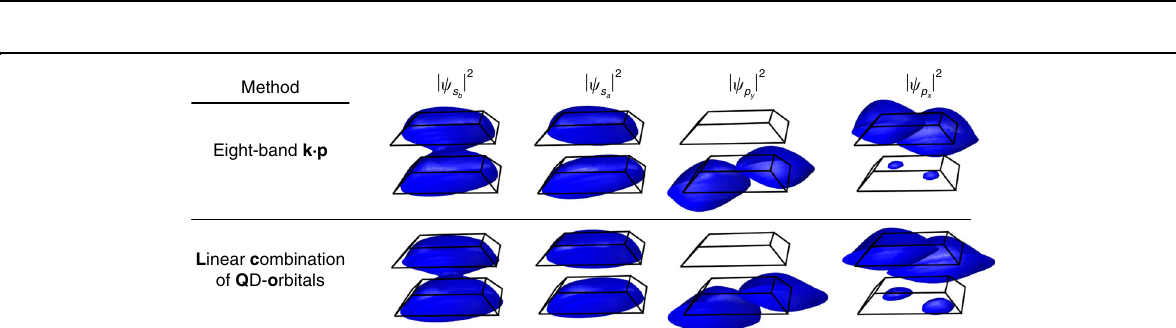
Fig. 4 The LCQO-method is illustrated schematically for a two-QD system. a A library of basis functions for various sorts of QD is generated. b The heterostructure is built using QDs from the library as building blocks, with the subsystems partially overlaid. The Hamiltonian of the system is constructed with strain and piezoelectric potentials taken into account. c The heterostructure ’ s eigenstates are expanded in the union of the basis (reproduced according to ref. 57 )